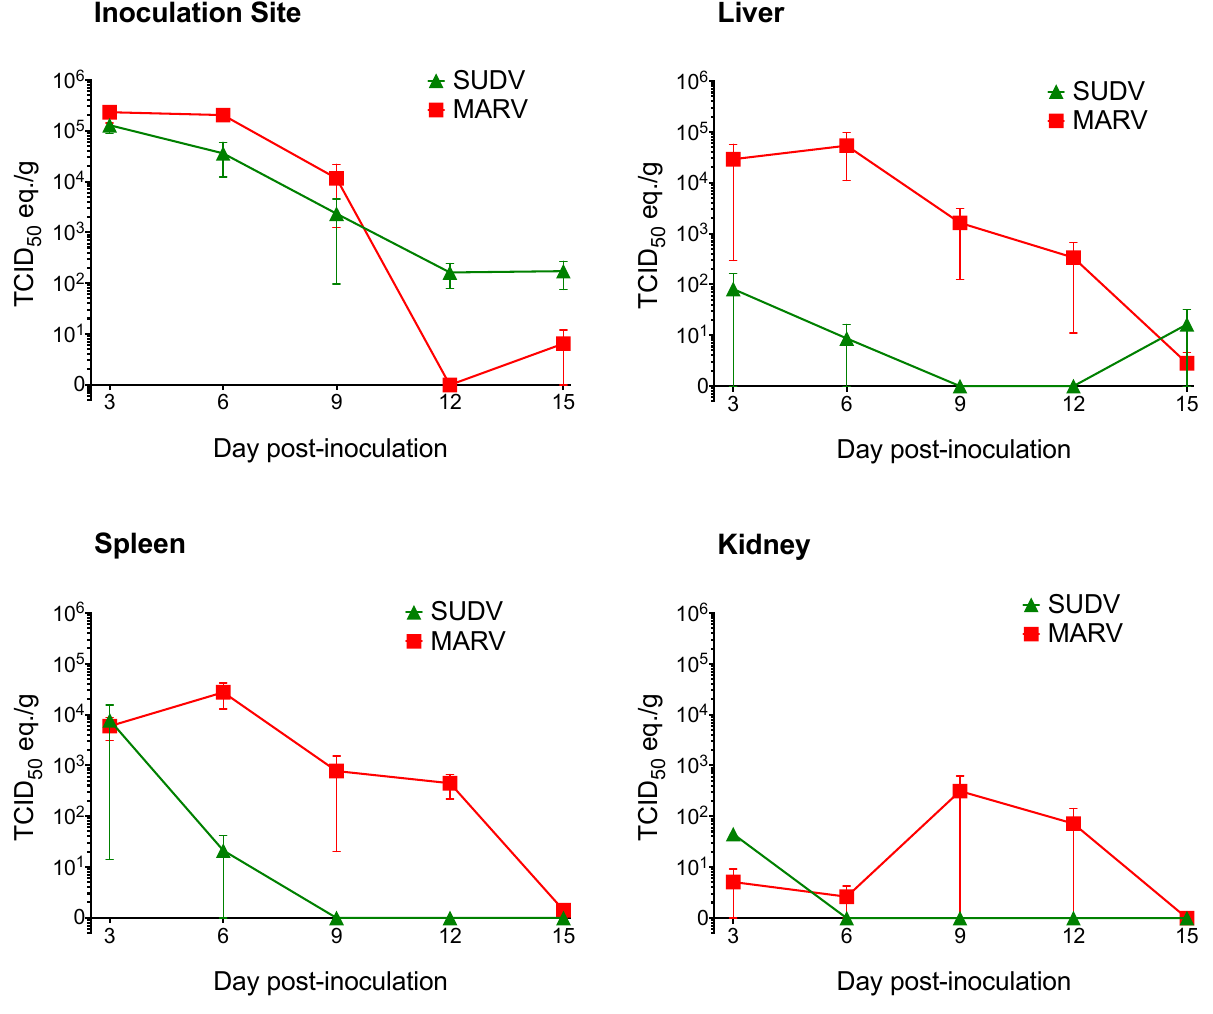
Figure 8. Comparison of Sudan virus and Marburg virus RNA levels in Egyptian rousette tissues (skin at the inoculation site, liver, spleen, and kidney) compared at days 3, 6, 9, 12, and 15 post-infection. Viral loads are expressed as 50% tissue culture infective dose (TCID 50 ) equivalents per gram, derived from quantitative reverse-transcriptase